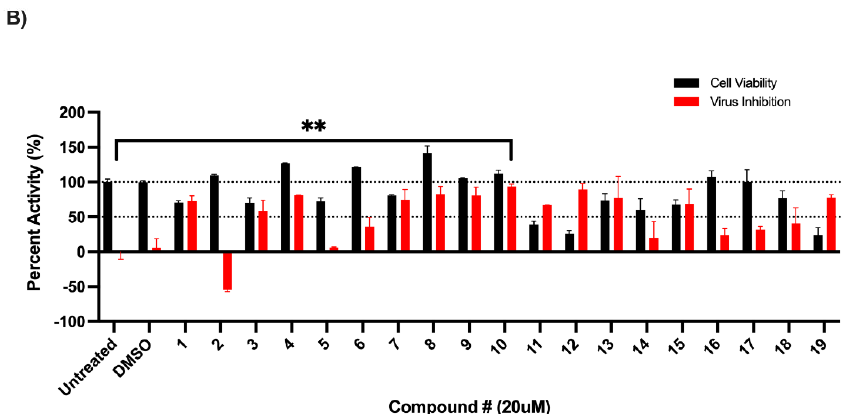
Figure 1. The screening and identification of potent sphingosine kinase (SK) inhibitors for activ- ity against CHIKV infection. ( A ) Method schema used to identify potent CHIKV inhibitors. Cells